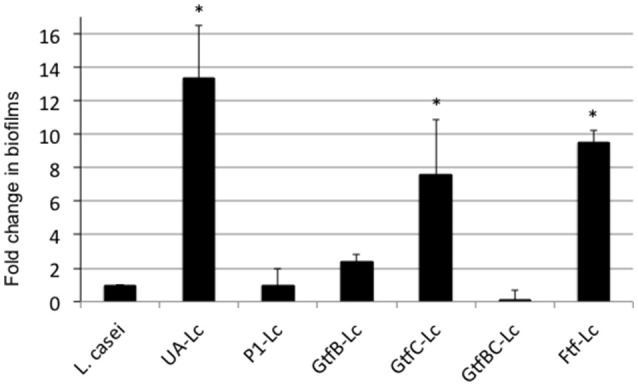
L. casei biofilm formation with S. mutans mutants. L. casei (Lc) was grown alone or together with S. mutans wild-type UA159 (UA) and its mutants deficient of P1, GtfB, GtfC, GtfBC, or Ftf in biofilm medium with glucose and sucrose for 48-h. Data are expressed as the ratio of L. casei biofilms (in colony-forming-units) in dual-species over those in mono-species, with * indicating significant differences at P < 0.001.